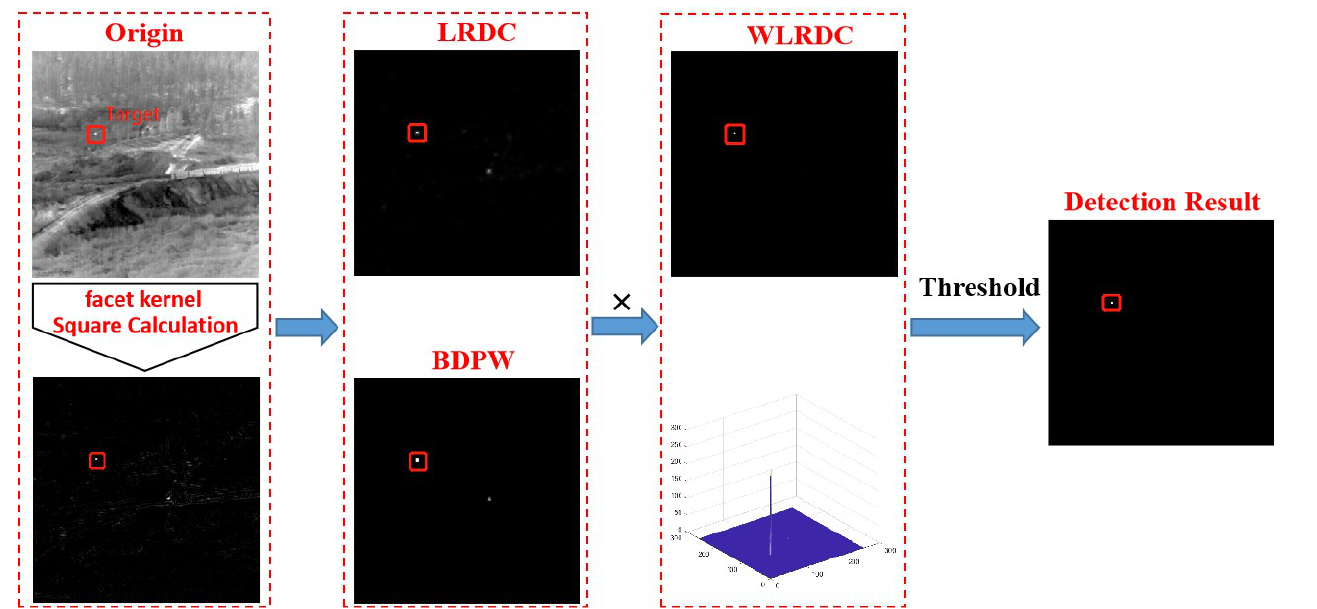
Figure 2. The overall target detection process of the proposed WLRDC method. The detection process includes facet kernel filtering, calculation of LRDC and BDPW, and WLRDC obtained by fusing the LRDC and